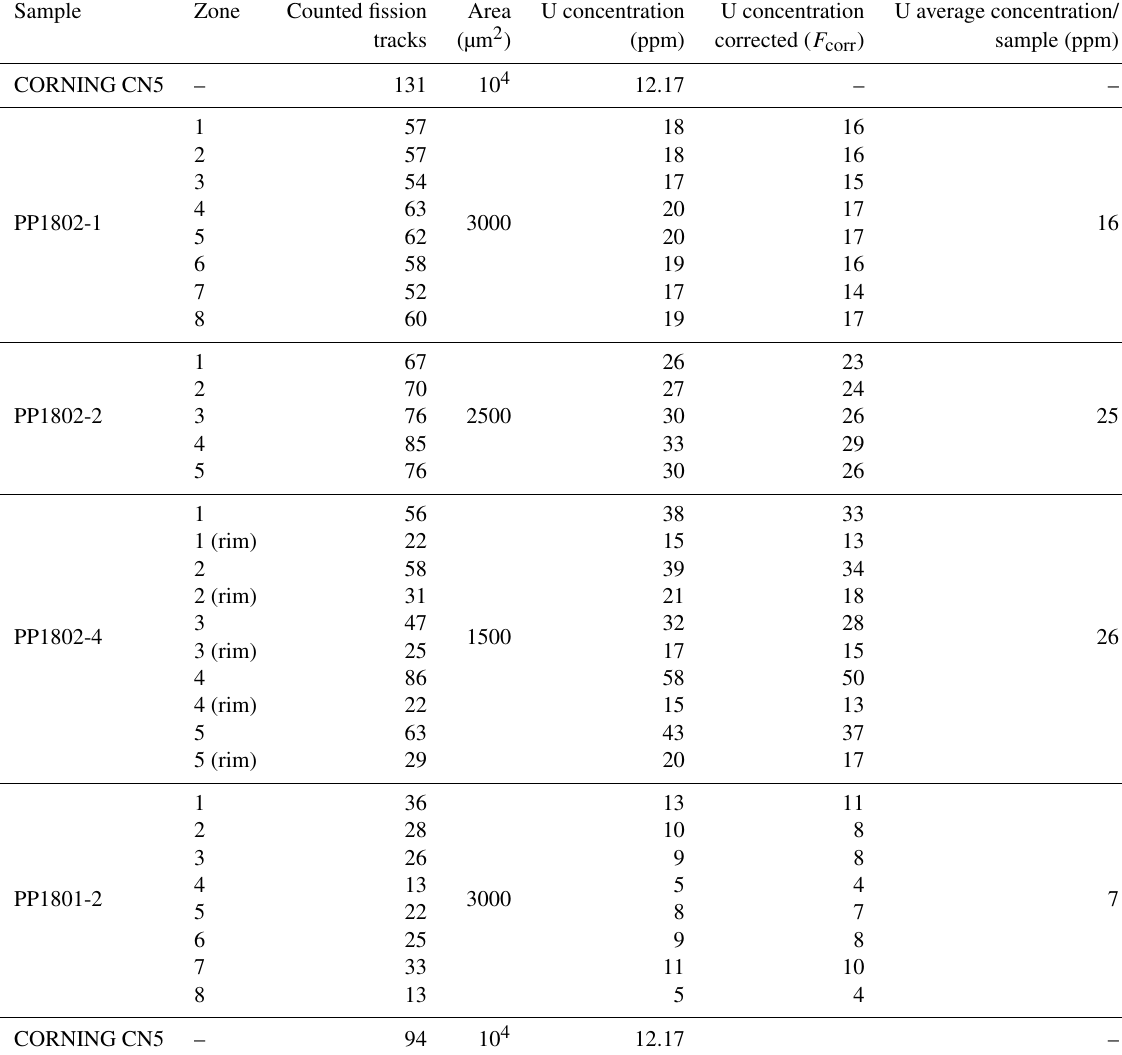
Table A2. Fission-track analytical results. Counted areas are distributed along Fl og 2 on different samples. The correcting factor employed for U concentration calculation on each sample depends on the counted area and followed a bracketing method (thanks to the two CN5 standards certified at